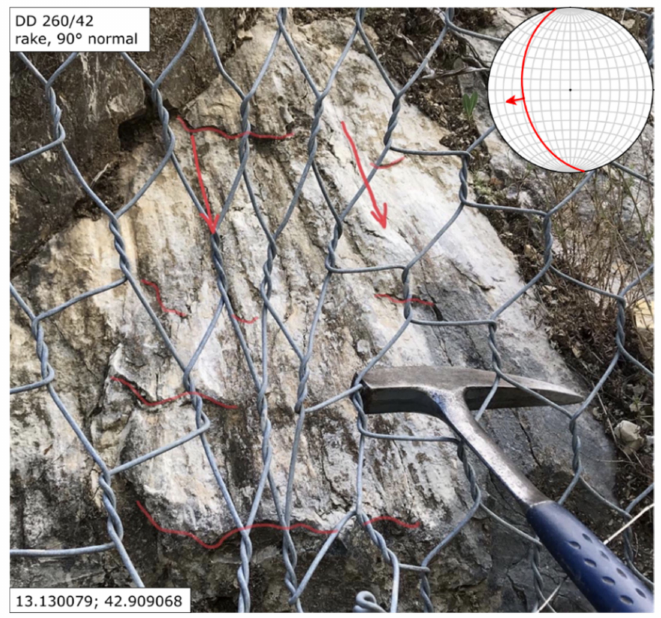
Figure 3. Outcrop of the new mapped fault with its kinematics represented in the stereo